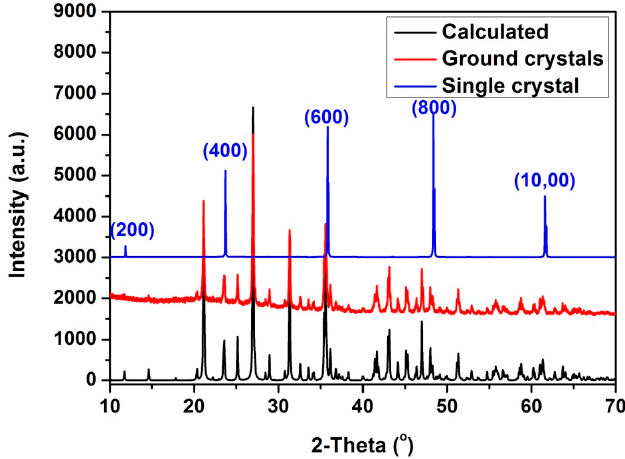
Figure 3. Calculated and experimental XRD patterns of Ba 2 Zn(BO 3 ) 2 crystals.